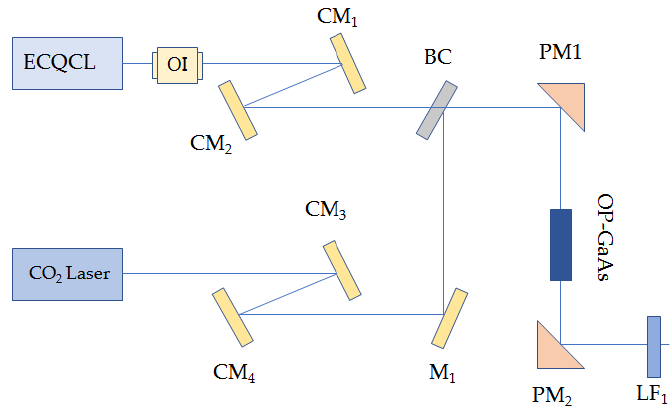
Figure 10. Schematic drawing of the mid-infrared laser setup.